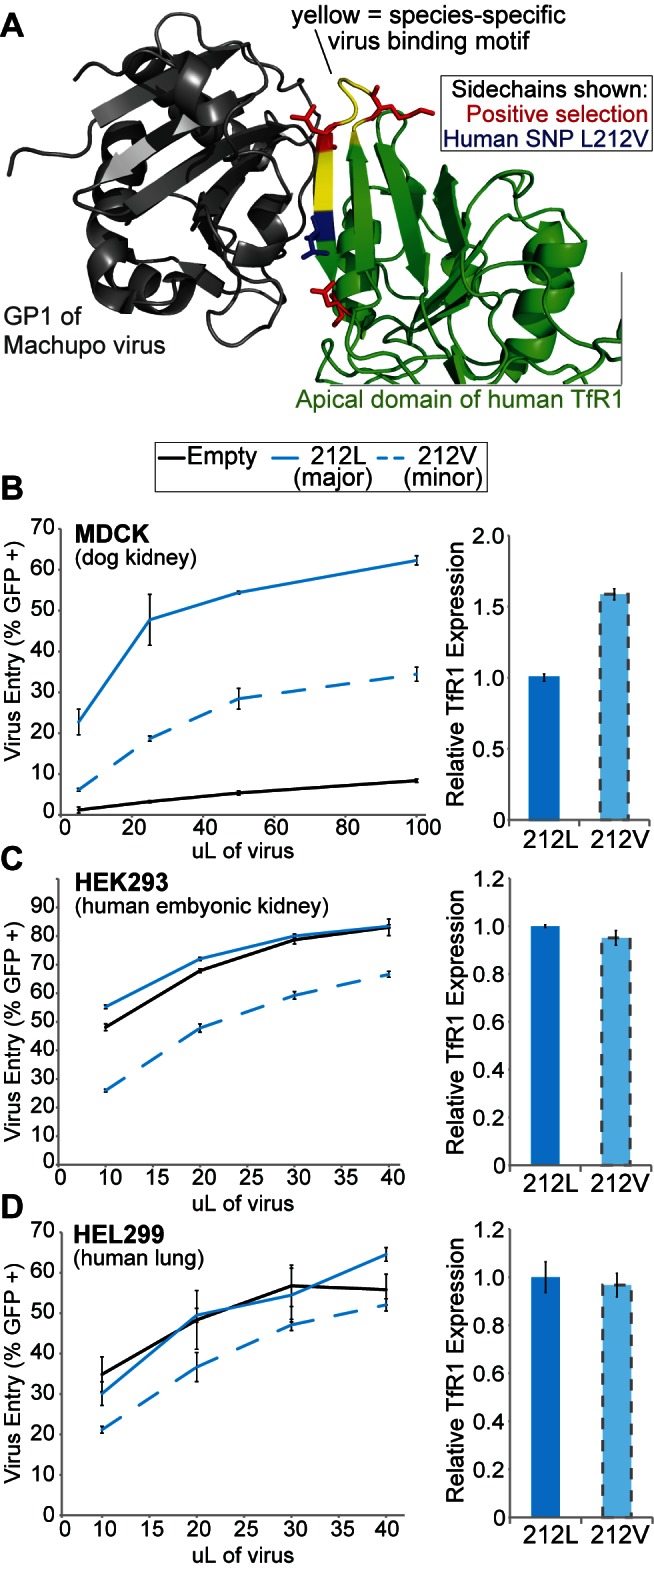
A human SNP in TfR1 is protective against Machupo virus entry.(A) The apical domain of human TfR1 is shown in green, in a co-crystal structure with the Machupo GP1 shown in grey (PDB 3KAS) [5]. The βII-1–βII-2 species-specific virus binding motif (residues 204–212) is highlighted in yellow. The side chains of residue positions identified as evolving under positive selection are shown in red. A human SNP (L212V; rs41301381) has been reported at position 212, shown in blue. (B) MDCK, (C) HEK293, or (D) HEL299 cells were stably transduced to express either 212L TfR1 or 212V TfR1 (or an empty vector) and then infected with various amounts of Machupo pseudovirus. Virus entry is scored by percentage of cells that become GFP positive (+). The error bars in the HEL299 experiment are large due to difficulty in sorting these cells. Nonetheless, this pattern of relative entry between the different TFR1 alleles expressed in HEL299 cells was observed in four independent experiments (not shown). (B, C, D, right-hand panels) Relative cell-surface expression of human TfR1 variants in each cell line was measured on live cells with a fluorescently labeled α-FLAG antibody. In all experiments, three replicates were performed and error bars indicate one standard deviation.